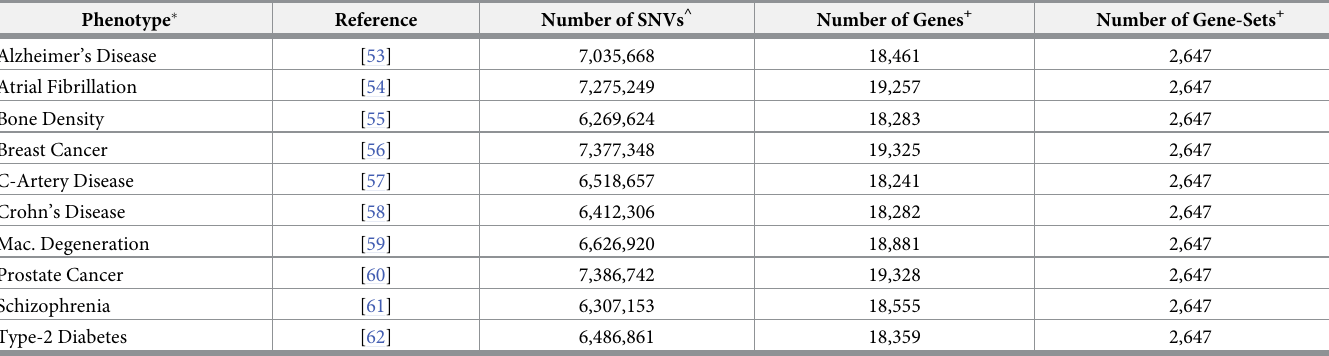
Table 2. GWAS datasets (summary statistics)